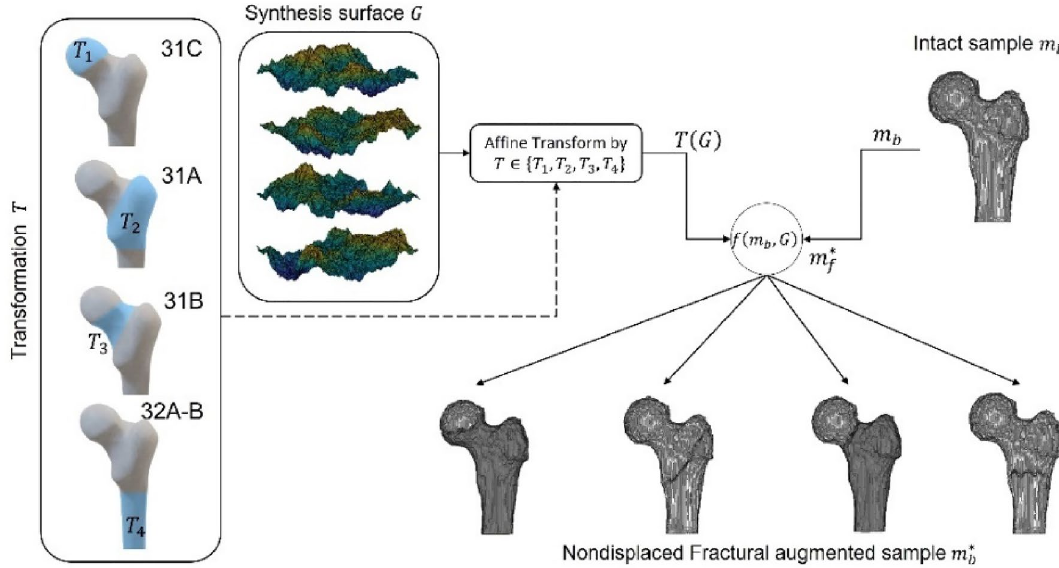
Figure 4. Workflow of the Fractural augmentation. The position of the synthesis surface applied affine transformation is shown in the blue area of the left box. The synthesis surface is randomized every time sampling. The equation f ( m b , G ) is described in Eqs. (3)and (4).